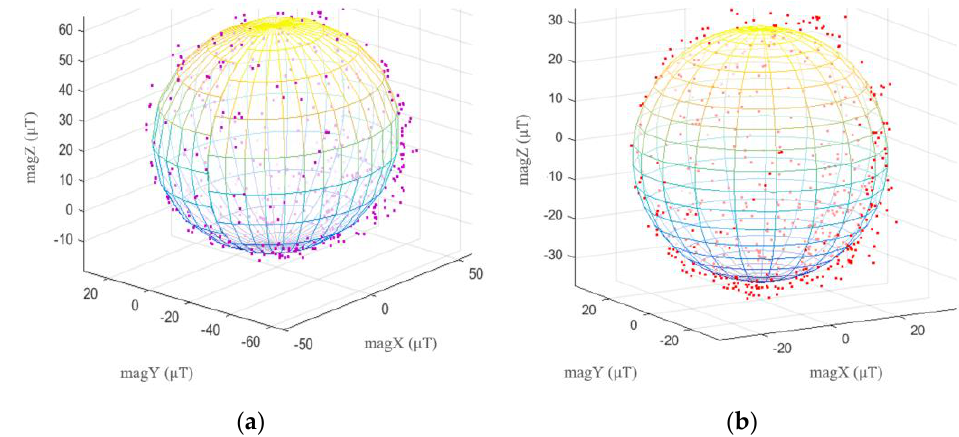
Figure 3. Magnetometer calibration; ( a ) Ellipsoid fitting model of raw magnetometer data; ( b ) Ellip- soid fitting model of calibration magnetometer data.